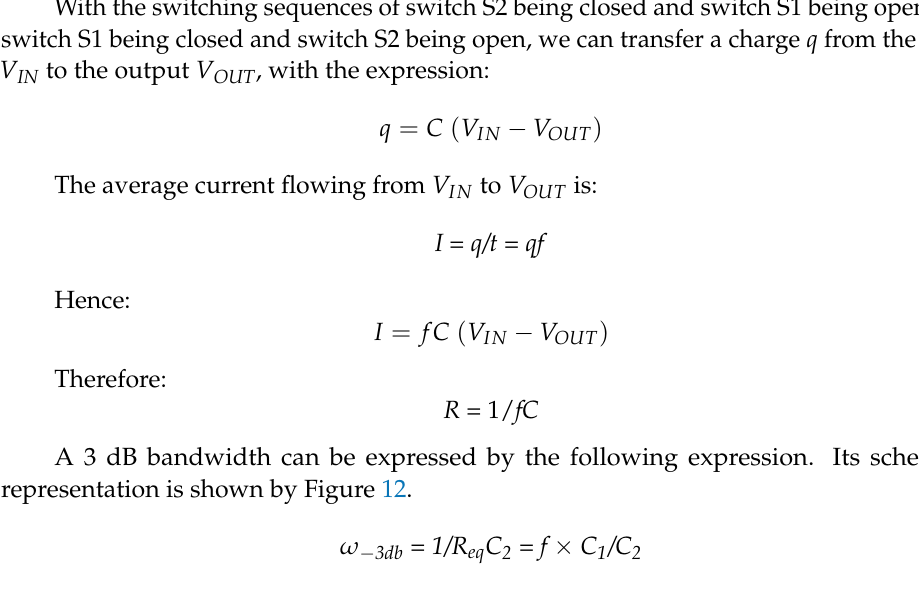
Table 4. Summary of the pre- and post-simulations.